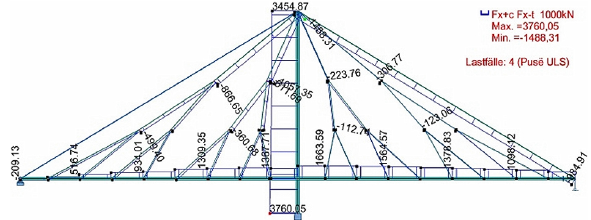
Figure 10. Diagram of the axial forces under asymmetric load